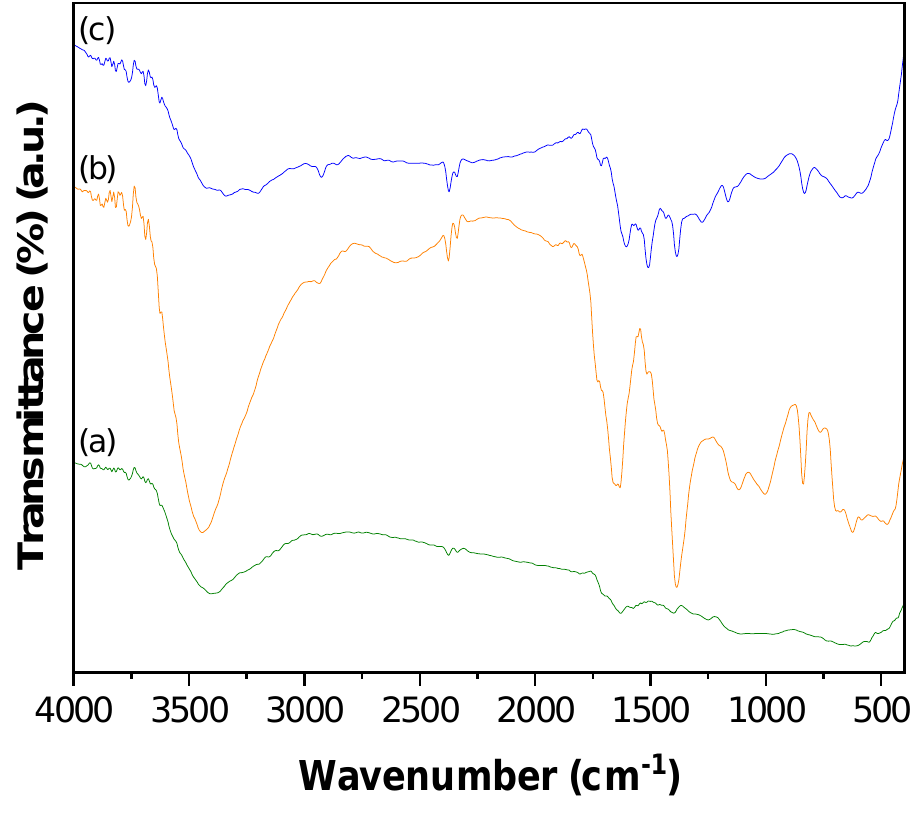
Figure 1. FT–IR spectra of ( a ) CNTs, ( b ) CNTs–PAMAM, and ( c ) Figure 1. FT – IR spectra of ( a ) CNTs, ( b ) CNTs – PAMAM, and ( c ) CNTs – PAMAM – Ag.